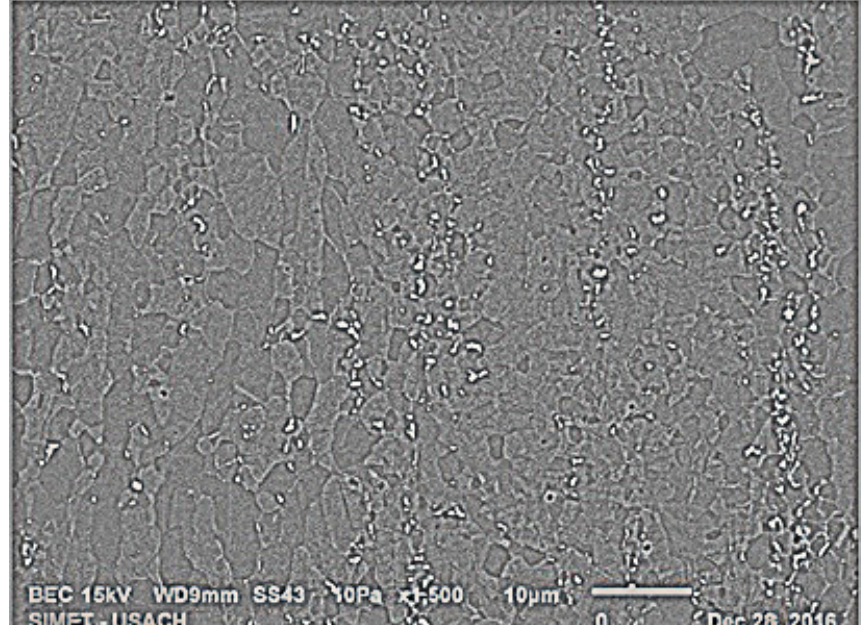
Figure 5. BEC image, showing Fe-Mn-Carbides in white and the austenitic matrix in grey. Cold- deformed 80% and annealed at 575 °C for 24 h.